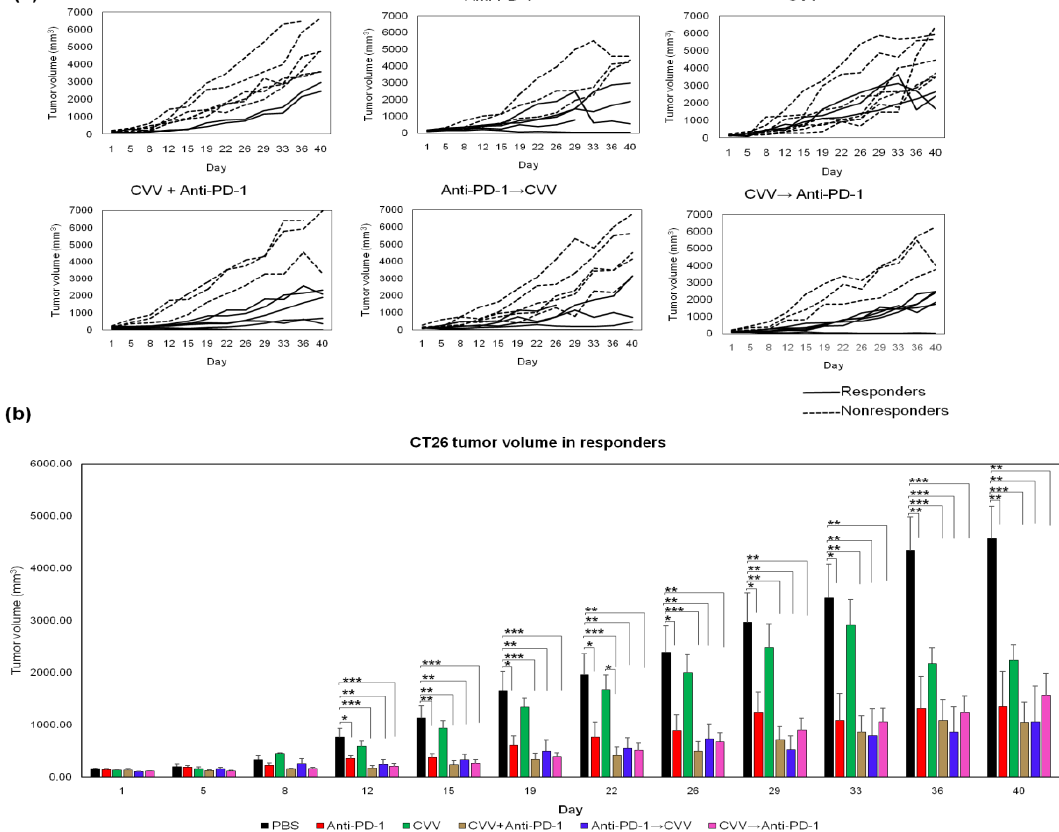
Figure 3. Monotherapy and combination therapy of CVV and anti-PD-1 and their therapeutic efficacy. ( a ) CT26 tumor burden in Balb/c mice after combination therapy. CT26 cells (5 × 10 6 cells/100 µL of 1X PBS) were used to induce subcutaneous tumors in the left flank of Balb/c mice. Tumor burden was monitored twice weekly. When the tumor volume reached >100 mm 3 , treatment was started (solid lines: responders, dashed lines: nonresponders). ( b ) On the basis of the tumor burden, mice were categorized as responders or nonresponders. Tumor volume in responders. * p < 0.05; ** p < 0.01; *** p < 0.001. CVV, cancer-favoring oncolytic vaccinia virus; PD-1, programmed cell death protein-1; PBS, phosphate-buffered saline; D1, day 1; D8, day 8; D15, day 15; D22, day 22; D29, day 29; D36, day 36; D40, day 40.